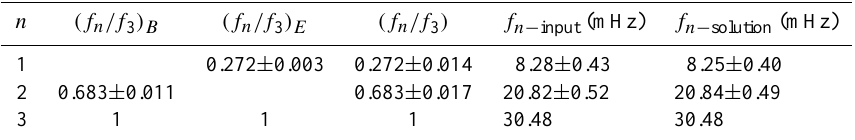
Table 3. Frequencies of toroidal harmonics for 10 September 2002